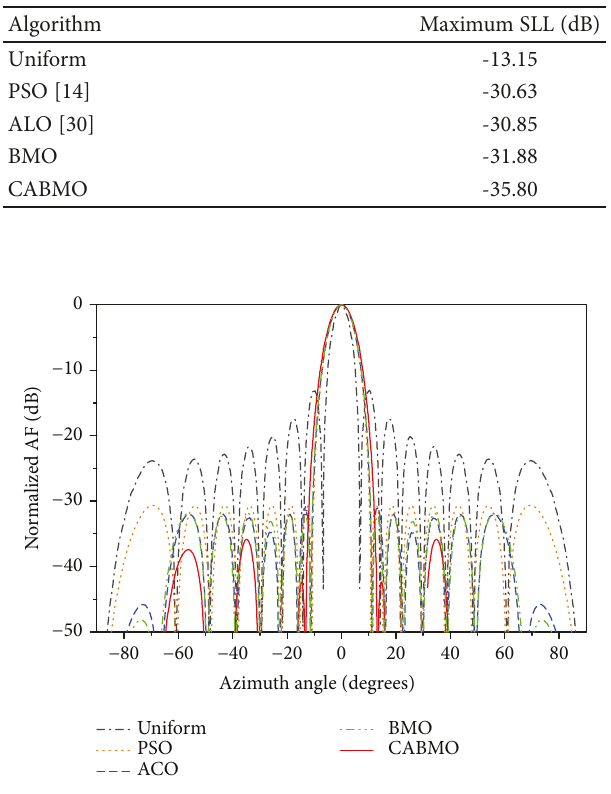
Figure 7: Nominalized AF of the 16-element LAA for case three.